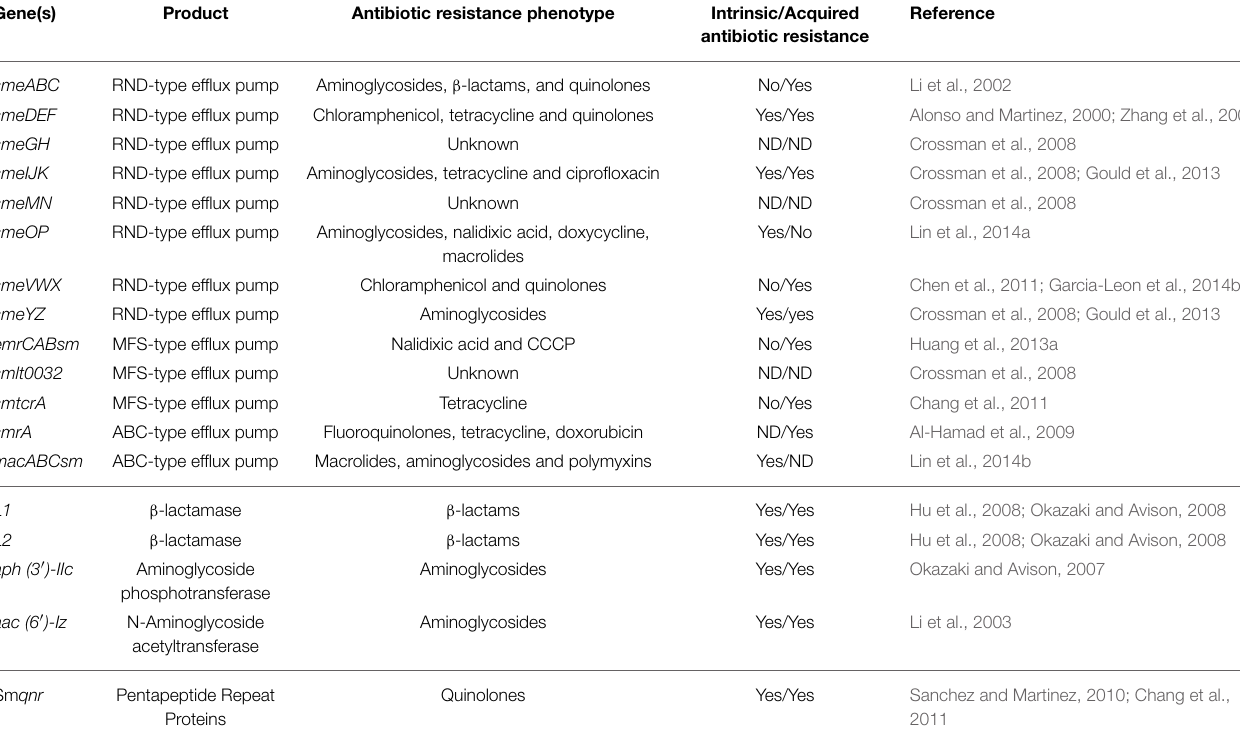
TABLE 1 | Summary of known antibiotic resistances genes in S. maltophilia, antibiotic resistance profile and their role in intrinsic and acquired resistance.